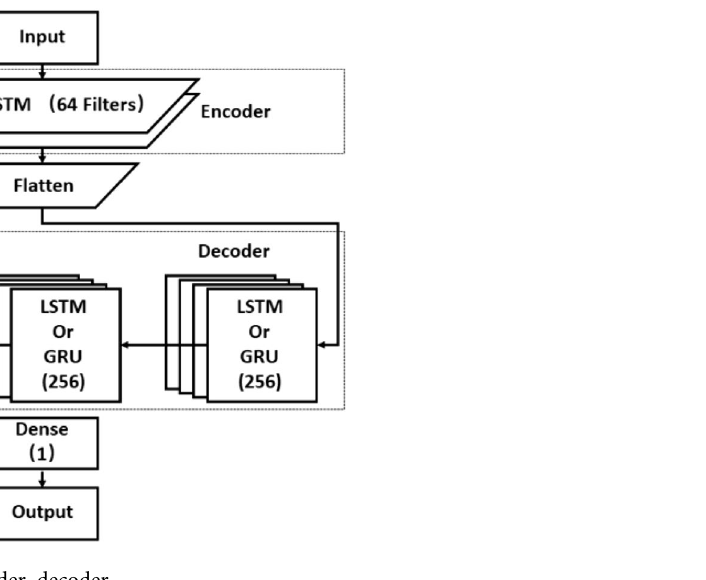
Figure 6. Conv LSTM